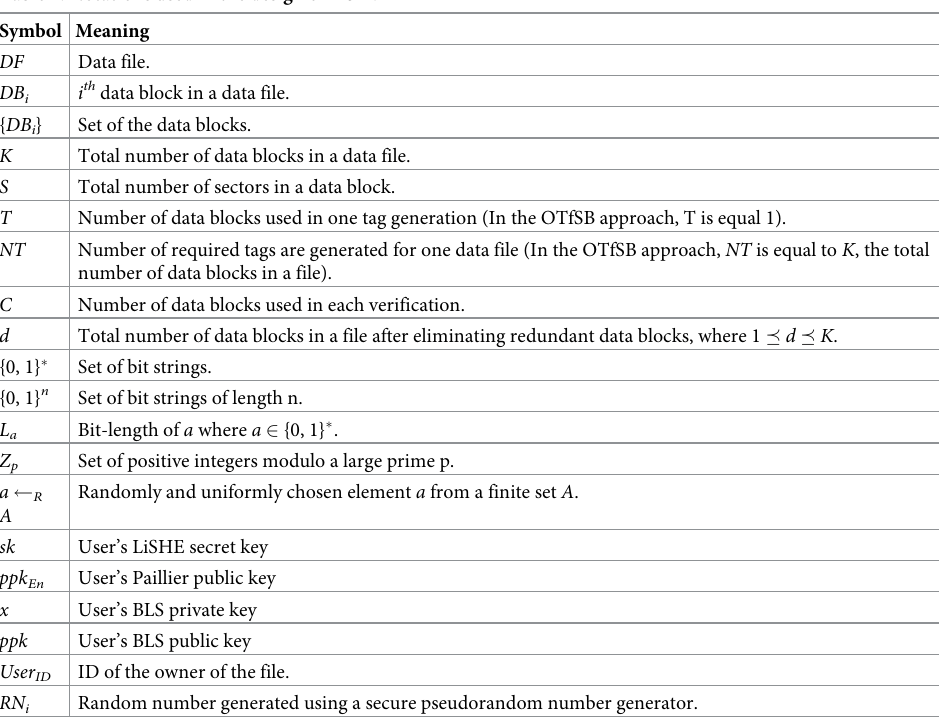
Table 2. Notations used in the design of